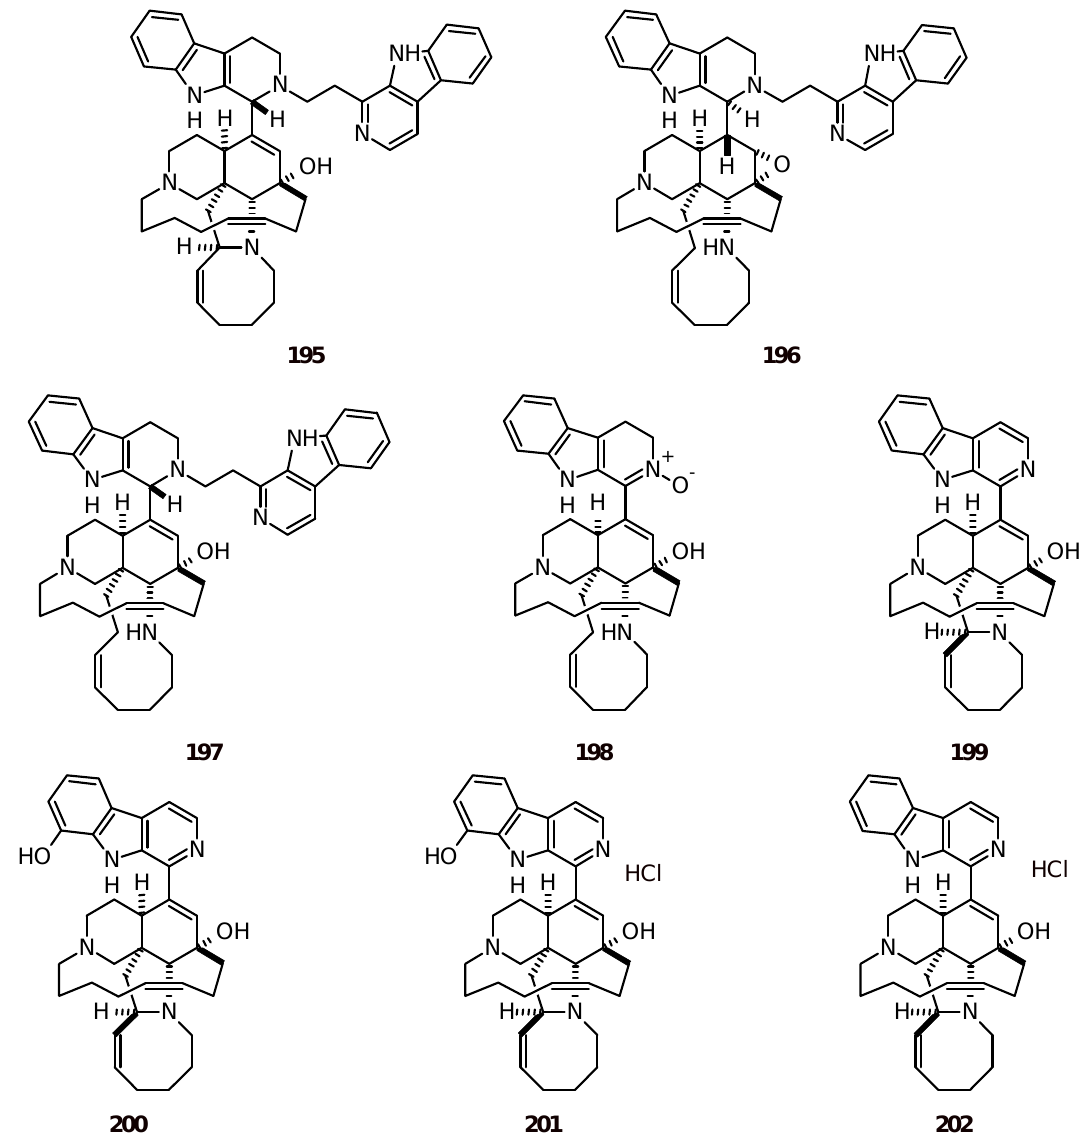
Figure 21 . Structures of alkaloids